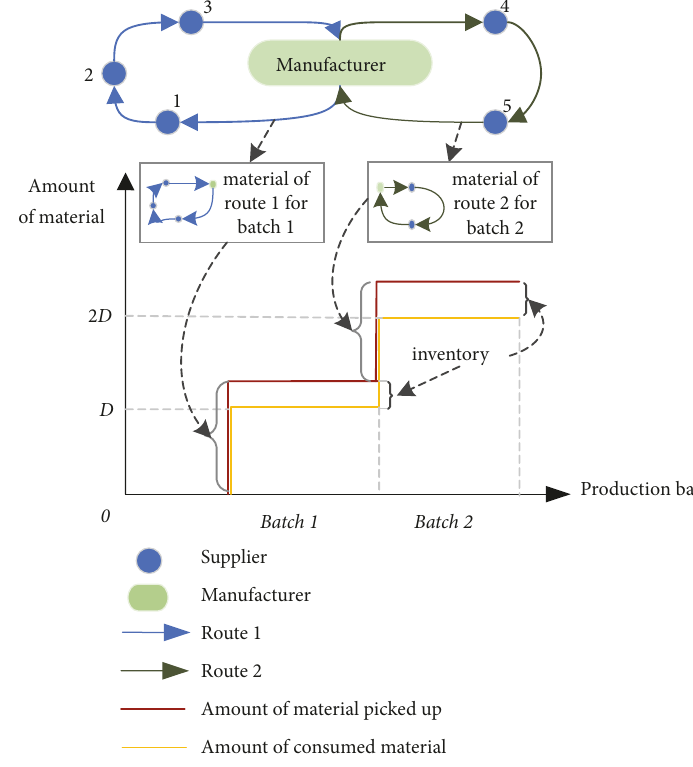
Figure 1: A schematic diagram of the